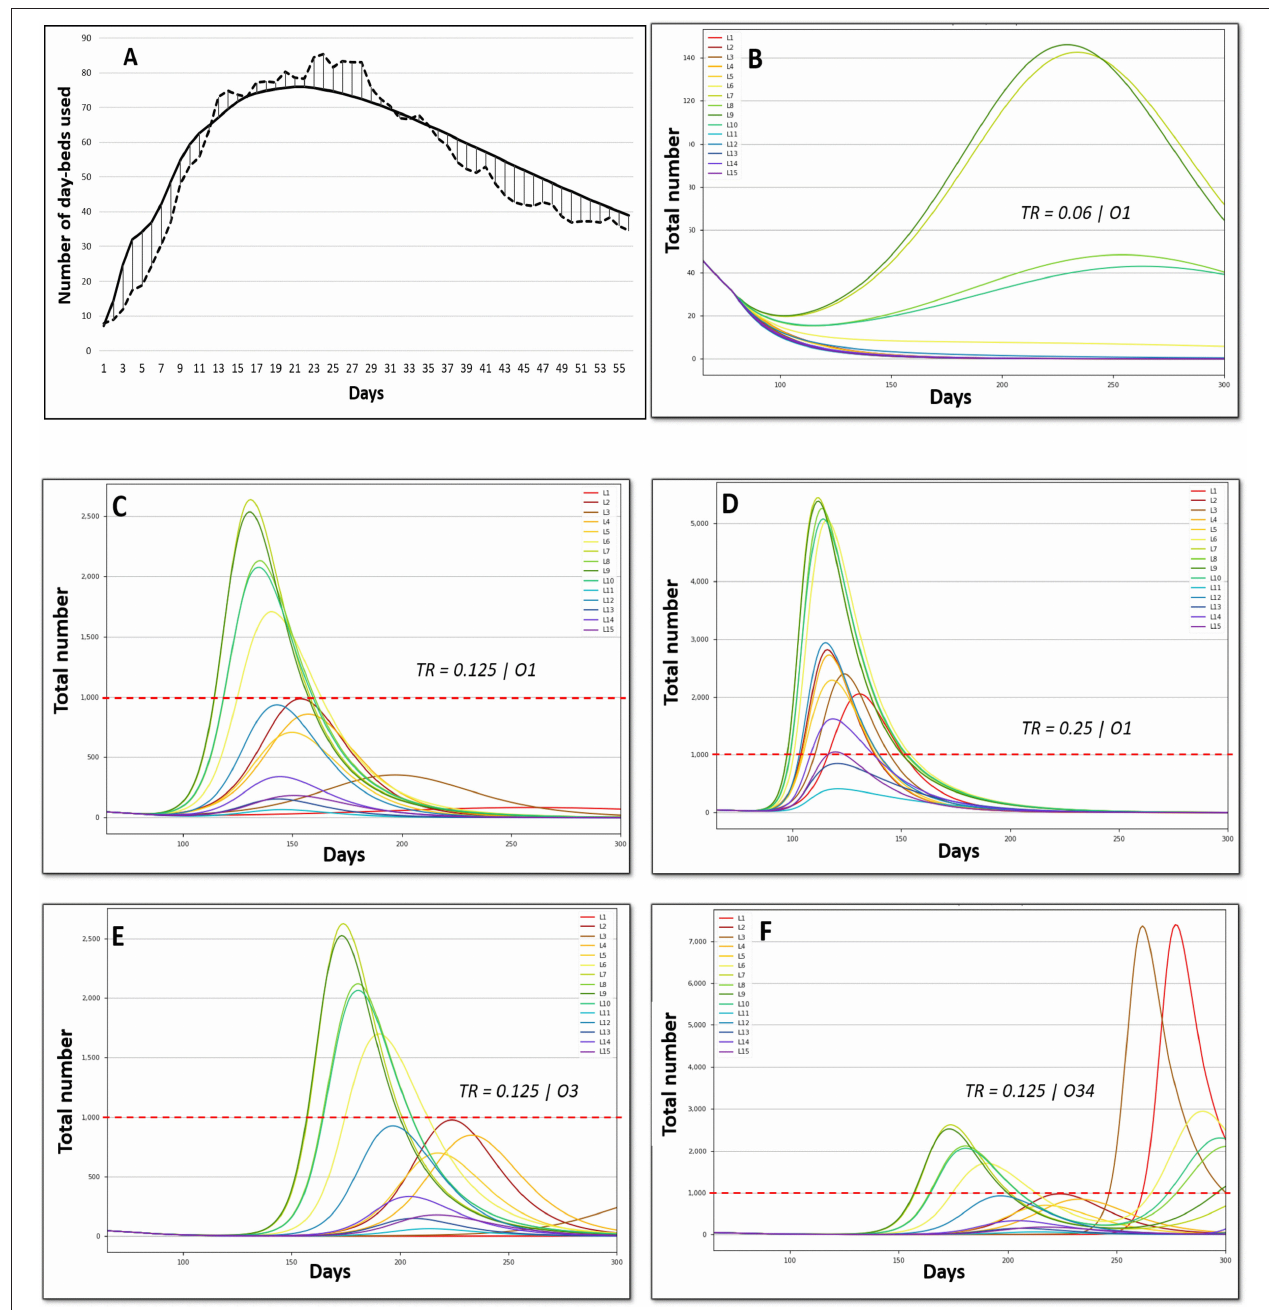
FIGURE 3 | Epidemiologic validation of the model. (A) Comparison between the predicted (solid line) and observed (dashed line) number of day-beds used. (B–F) Number of daily beds used in hospital (CIU excluded). The red dashed line represents the hospital capacity. Tr, transmission rate; Option 1, abrupt monitored lockdown lift early in phase 2; Option 3, progressive monitored lockdown lift on 8 weeks; Option O34, progressive total lockdown lift (phase 3).